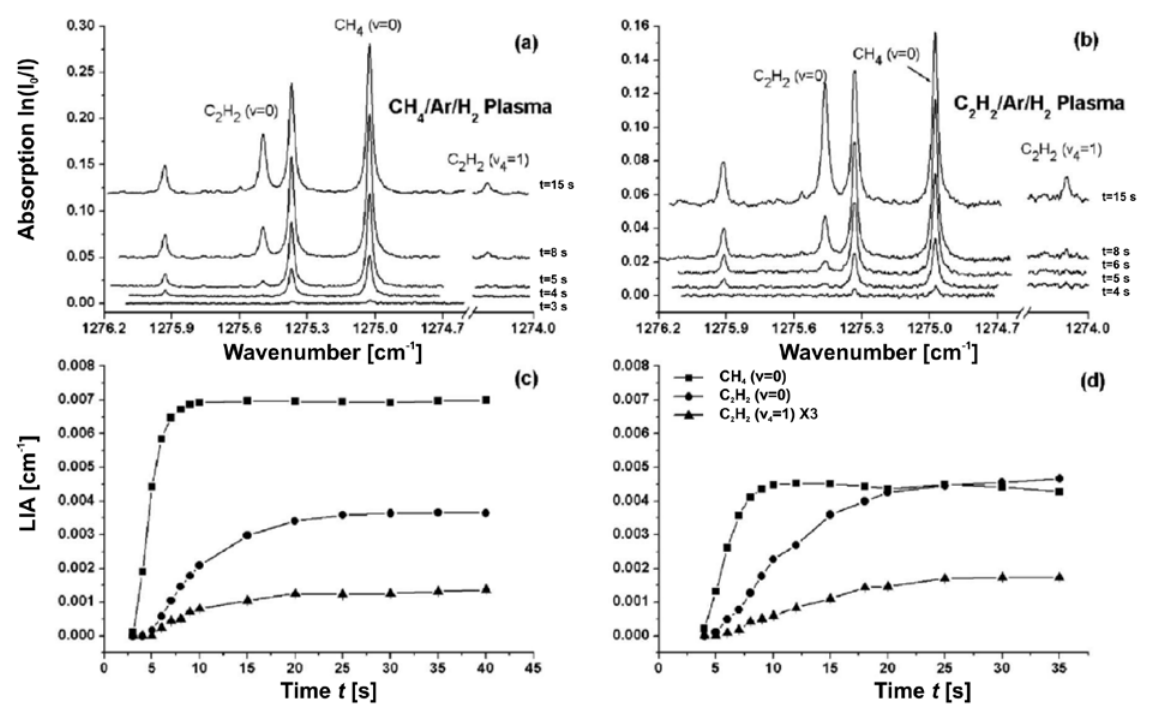
Figure 9. Intra pulse absorption spectra measured in a MW diamond deposition discharge (199.5 mbar, 1.5 kW, 565 sccm total gas flow) during addition of (a) 25 sccm CH 12 sccm C H to a pre-existing 40 sccm Ar—(balanced) H discharge. Plots (c) and (d) show 2 2 2 the LIAs for the CH ( ν = 0), C H ( ν = 0), and C H ( ν = 1) transitions as a function of 4 2 2 2 2 4